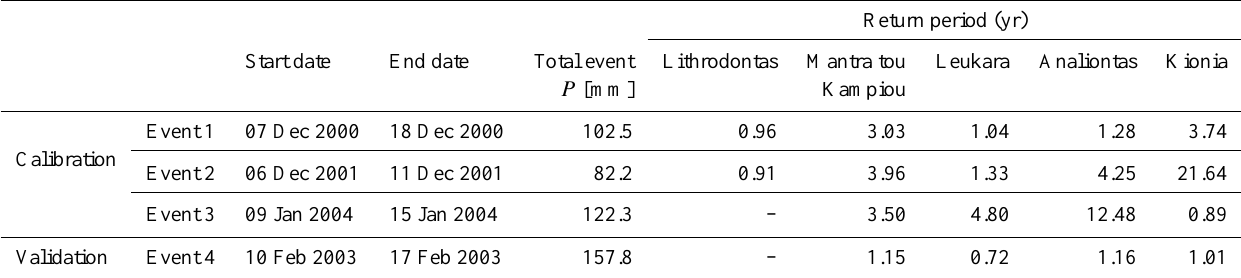
Table 3. List of calibration and validation events. The precipitation represents the average precipitation of the entire watershed. The return period for each rain gauge for each event is also